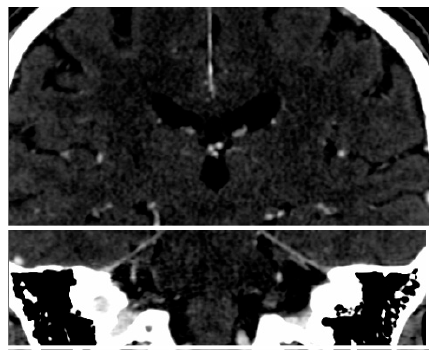
Figure 1. ROI in bilateral hippocampal regions (the white box).